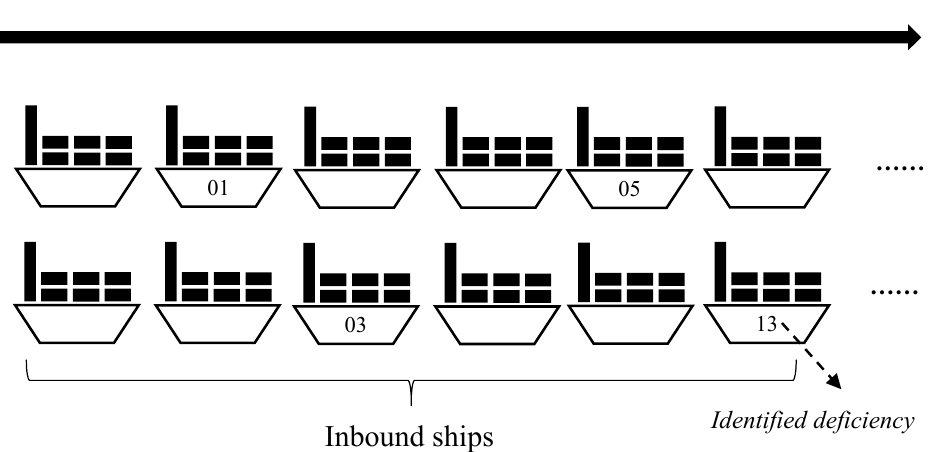
Figure 2. Illustration of time-series inspection process.